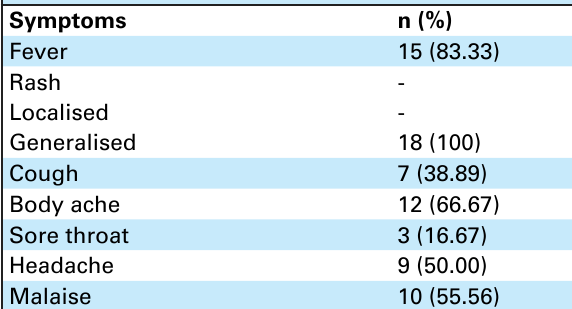
Table 2. Clinical features of chickenpox among cases (n= 18).